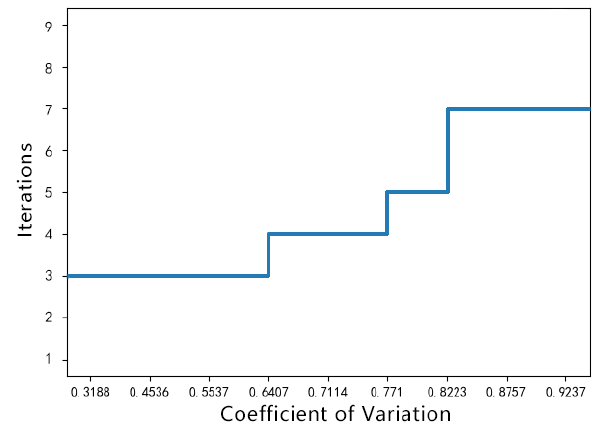
Figure 6. Relationship between number of iterations and the coefficient of variation. After gray value compression, the histogram features of the noisy image before and after gray compression were extracted and compared. The histogram is shown in Figure 7. It can be seen that the gray distribution in the histogram becomes relatively concentrated, which greatly reduces the fluctuation of the gray value in the noisy image, and the wave crest is close to the original gray value.